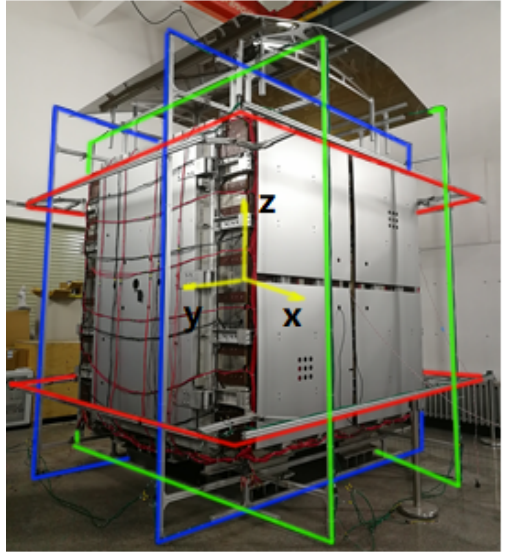
Figure 1. The MSR and the square Helmholtz coils at